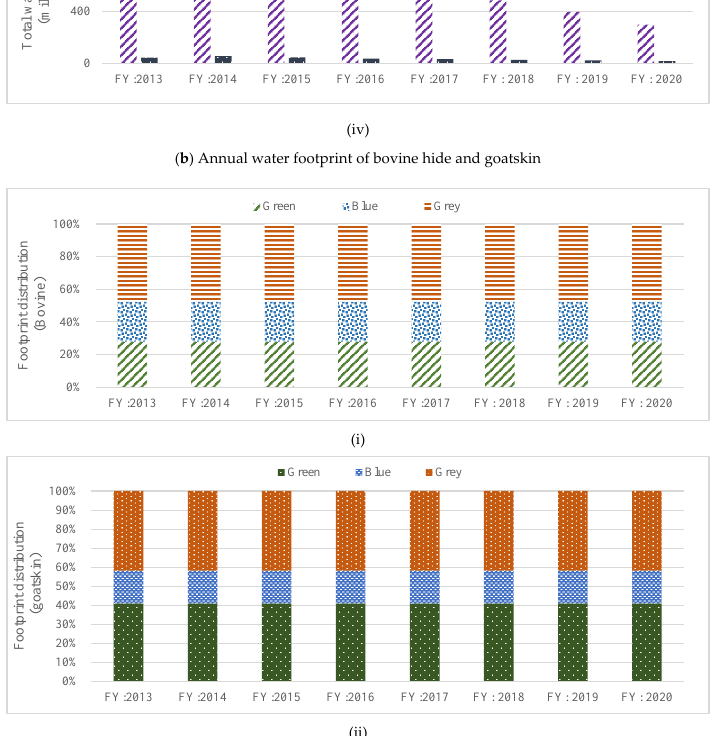
( c ) Green, blue and grey water footprint distribution (%) of bovine and goatskin